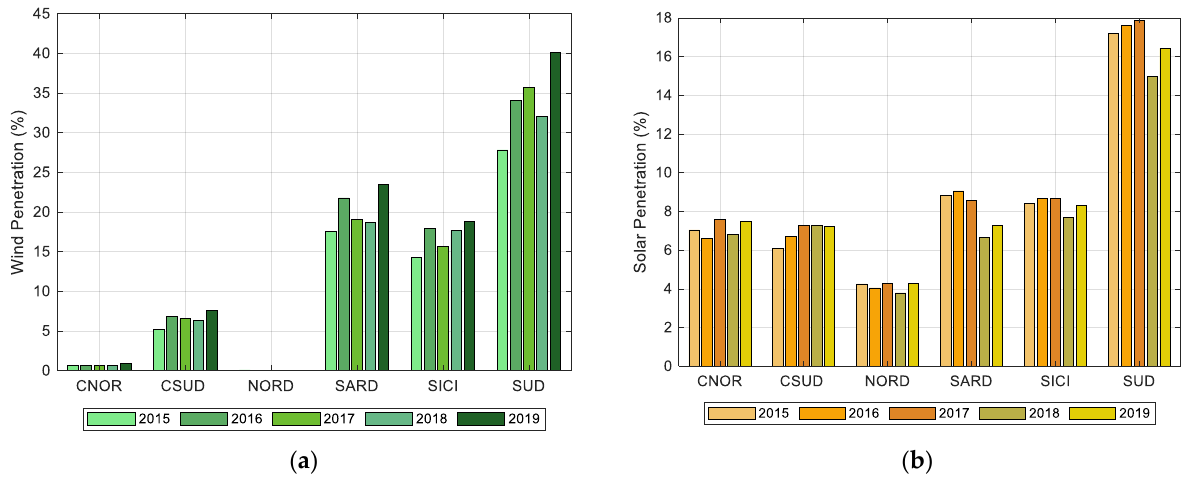
Figure 4. Wind ( a ) and solar ( b ) penetration in each zone; 2015 to 2019 [25].